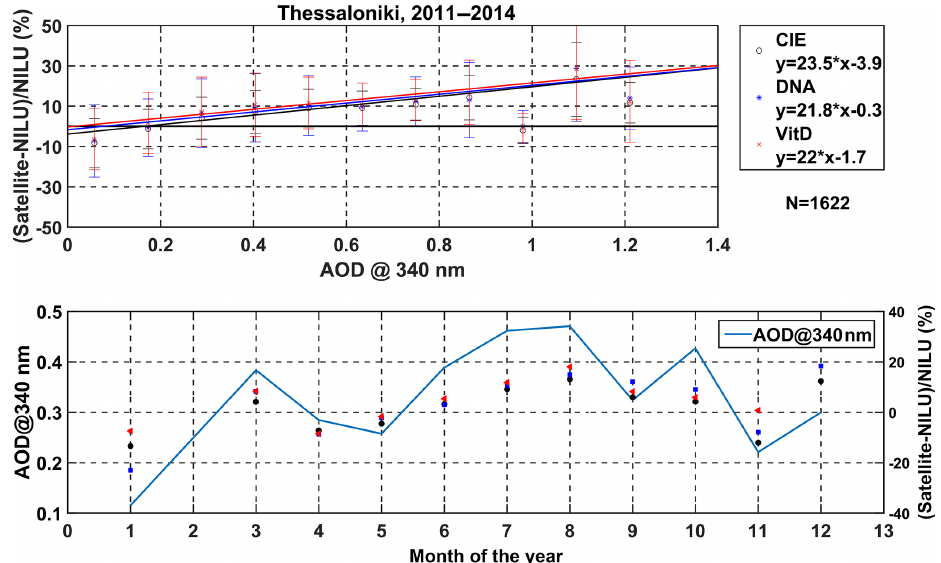
Figure 10. Relative differences of satellite-based and ground-based UV 10min doses as a function of AOD at 340nm for cloudless cases at Thessaloniki in the period 2011–2014. The statistics are provided in the form of mean and standard deviation of the differences within 11 bins of AOD values. The least squares linear fits for the three doses are also provided (upper panel). Monthly mean values of AOD at 340nm along with the mean monthly values of the relative differences presented in the upper panel under cloud-free cases are also provided (lower